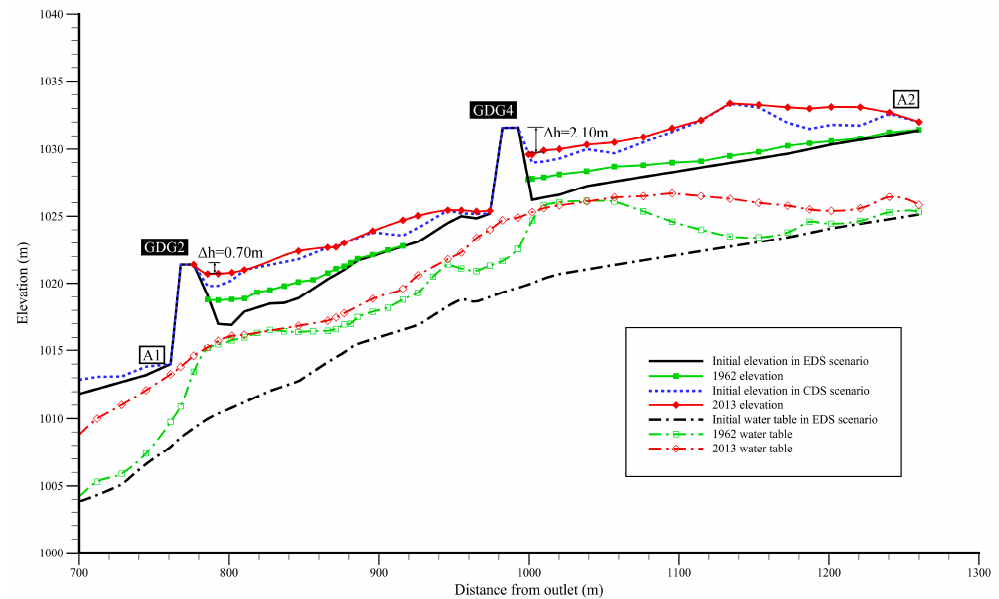
Figure 11. Surface elevation changes and water table changes of GDG2-GDG4 dam-controlled reach in EDS scenario and CDS scenario. Note that the simulation results in the end of month 11 of each year were used for comparison.